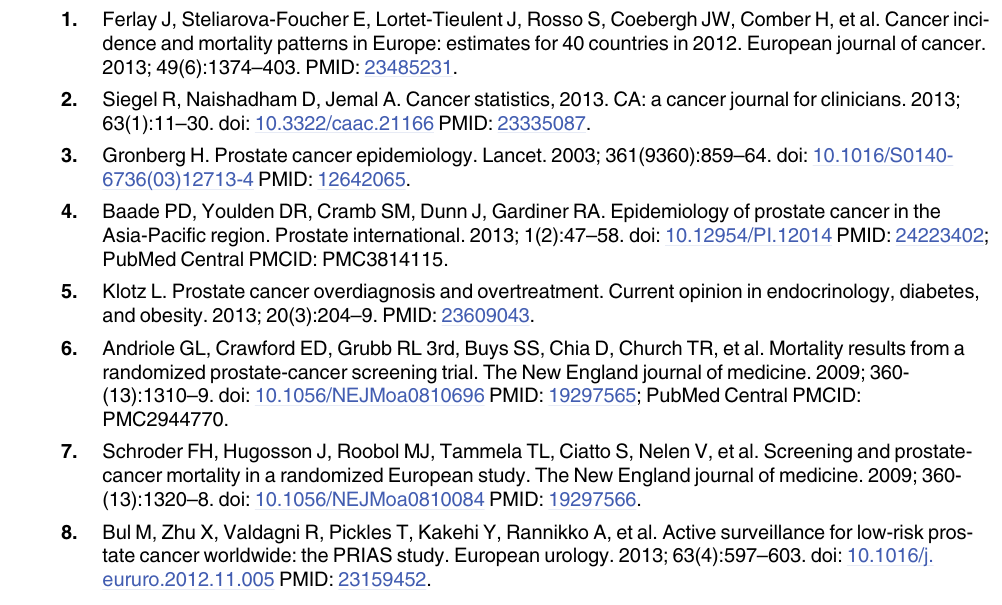
S2 Table. Core2 β -1,6- N -acetylglucosaminyltransferase-1 status and pathological parame- ters. S3 Table. Patient data of post-digital rectal examination urine